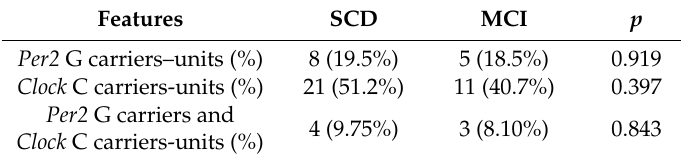
Table 1. Comparison between prevalence of Clock and Per2 polymorphisms in SCD and MCI